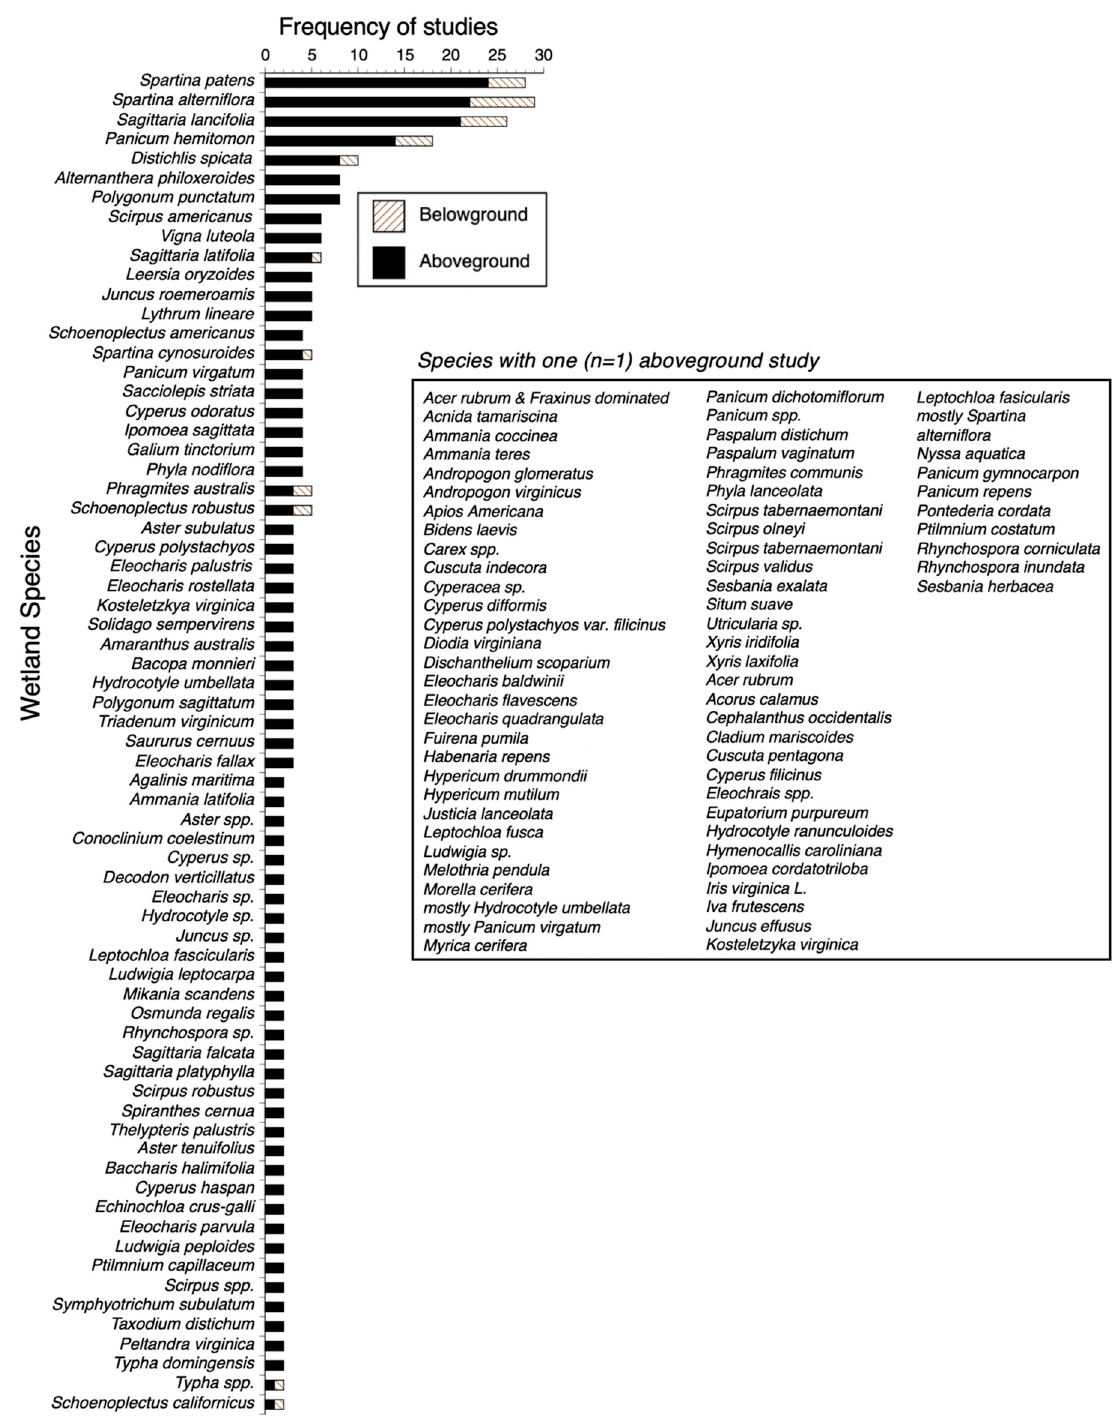
Figure 6. Frequency distribution of ecological studies assessing above and belowground vegetation biomass per species. Wetland species listed inside the frame represent those species with only one (n = 1) aboveground study. Data encompass the period 1976–2015.